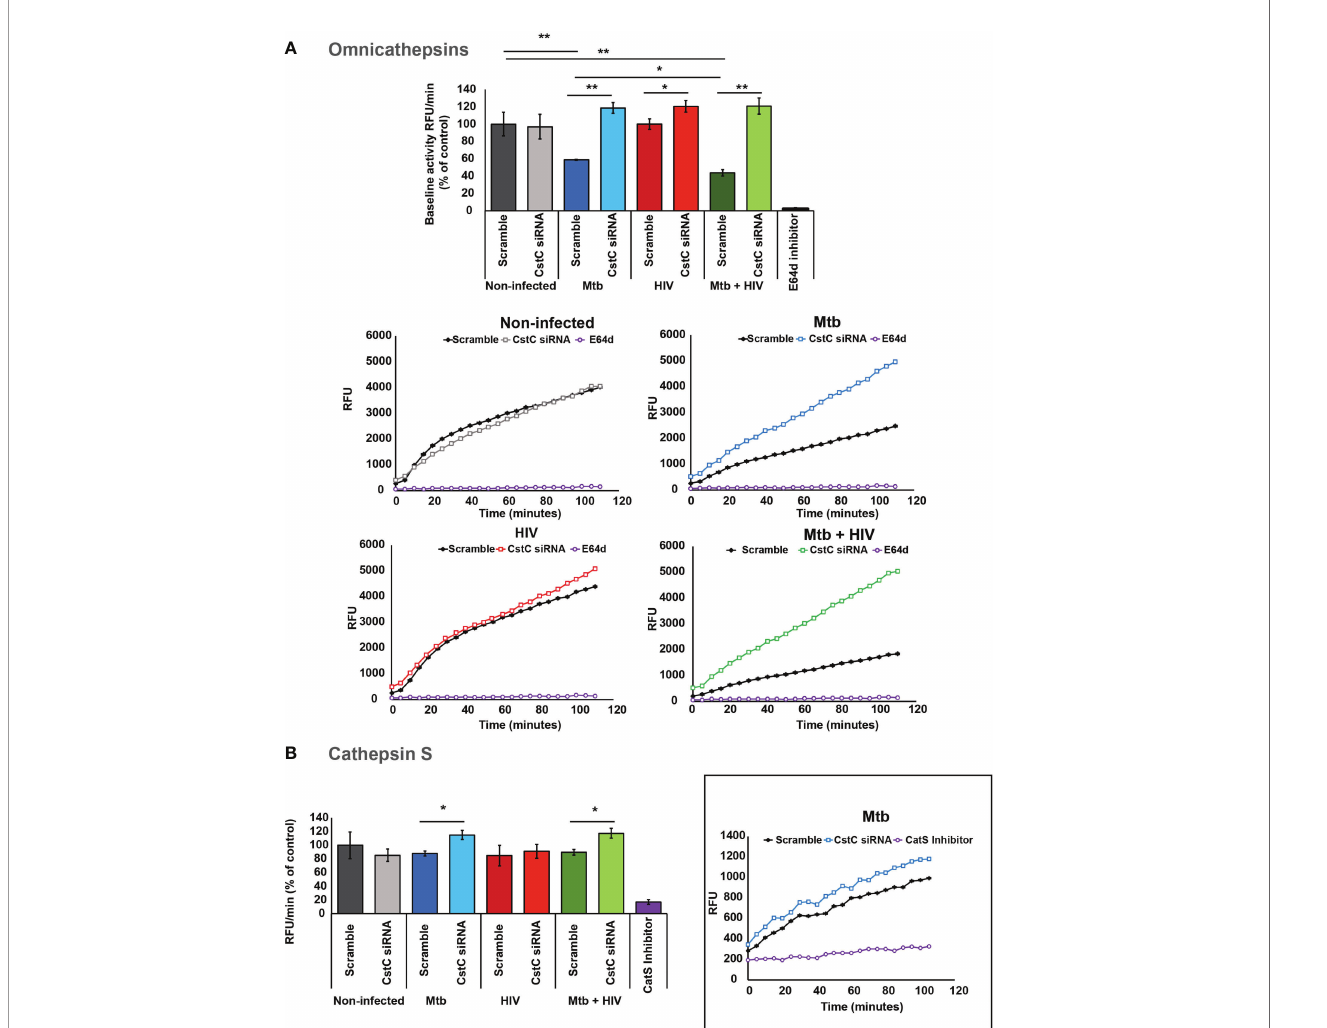
FIGURE 4 | SiRNA-mediated gene silencing for CstC alter cathepsin activity in human Mø infected with Mtb. (A) OmniCathepsin or (B) cathepsin S activity alone was monitored with a speci fi c fl uorogenic substrate every 5 min in live cells (scramble-control and CstC-silenced cells), or with speci fi c inhibitors (E-64d or ZFL- COCHOO for cathepsin S). The slope of fl uorescence emission in the scramble control of non-infected cells was represented as 100%, and the effect of each sample was calculated as a percentage relative to control. Data are represented as average from three independent experiments, and the error bars represent standard error (* p < 0.01, ** p < 0.001; n = 3). Mtb, Mycobacterium tuberculosis ; Mø,